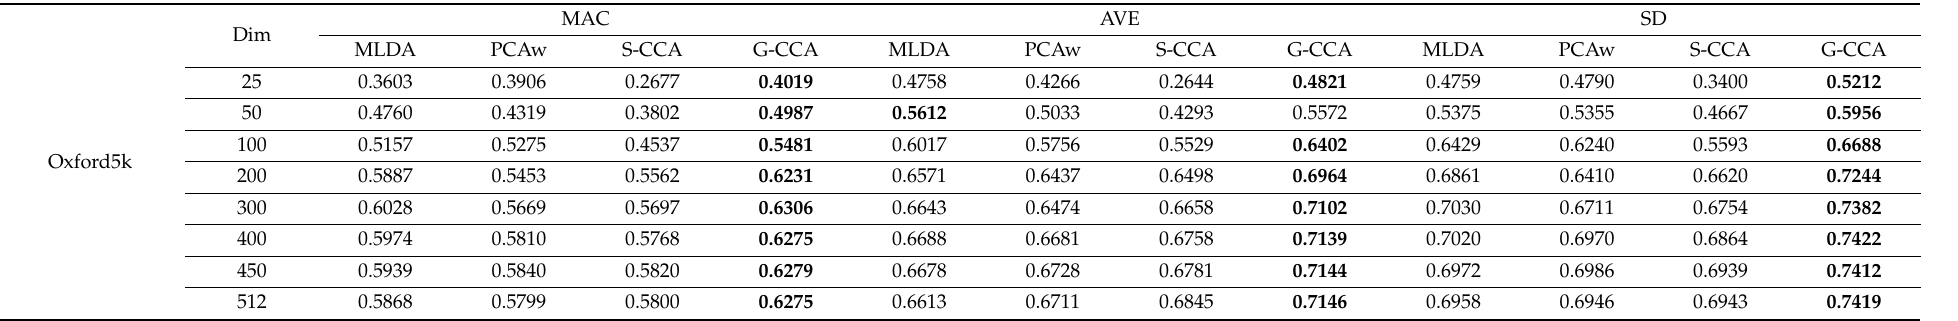
Table 4. Evaluation results from 120k-SfM on Oxford5k, R Oxford, Paris6k, and R